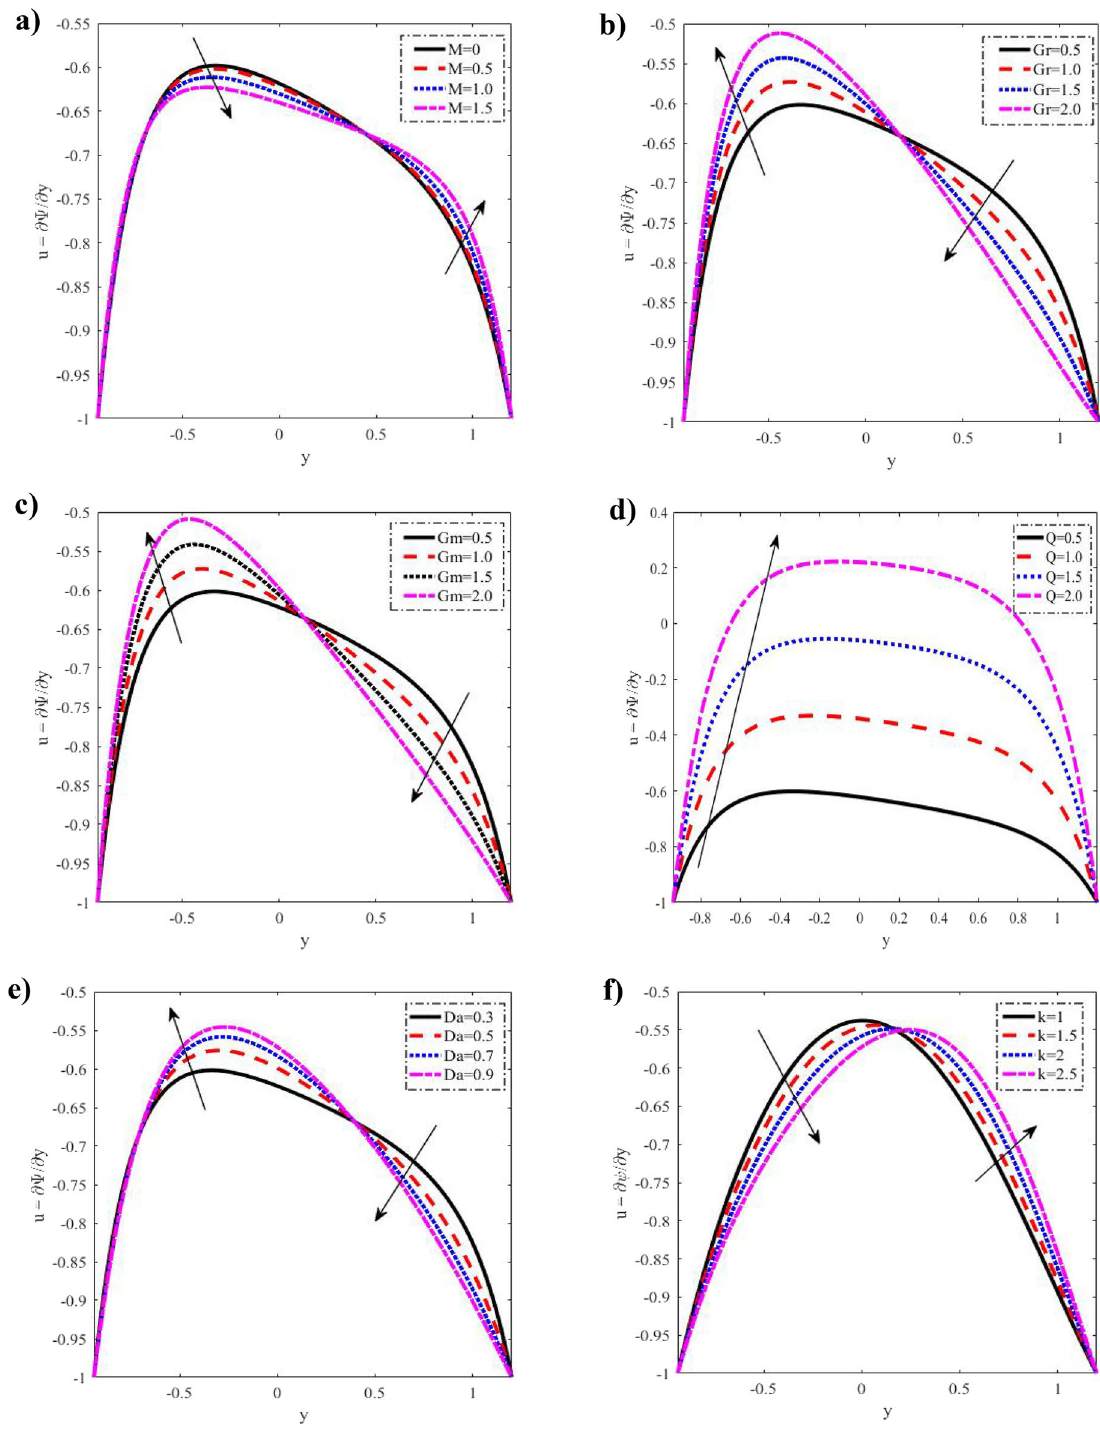
Figure 2. Discrepancies of the velocity u against the y-axis. ( a ) For different values of M . ( b ) For different values of Gr . ( c ) For different values of Gm . ( d ) For different values of Q . ( e ) For different values of Da . ( f ) For different π x = 0.1, a = 0.3, b = 0.5, d = 1, φ = , k = 1, Gr = 0.5, (cid:31) 1 = 0.5, Br = 0.1. Pr = 1, values of k . When 3 Nt = 0.2, Nb = 0.2, q = − 1.5, µ = 0.2, Gm = 0.5, d 1 = 0.3, γ 1 = 0.5, Da = 0.3, Ec = 0.1, M =